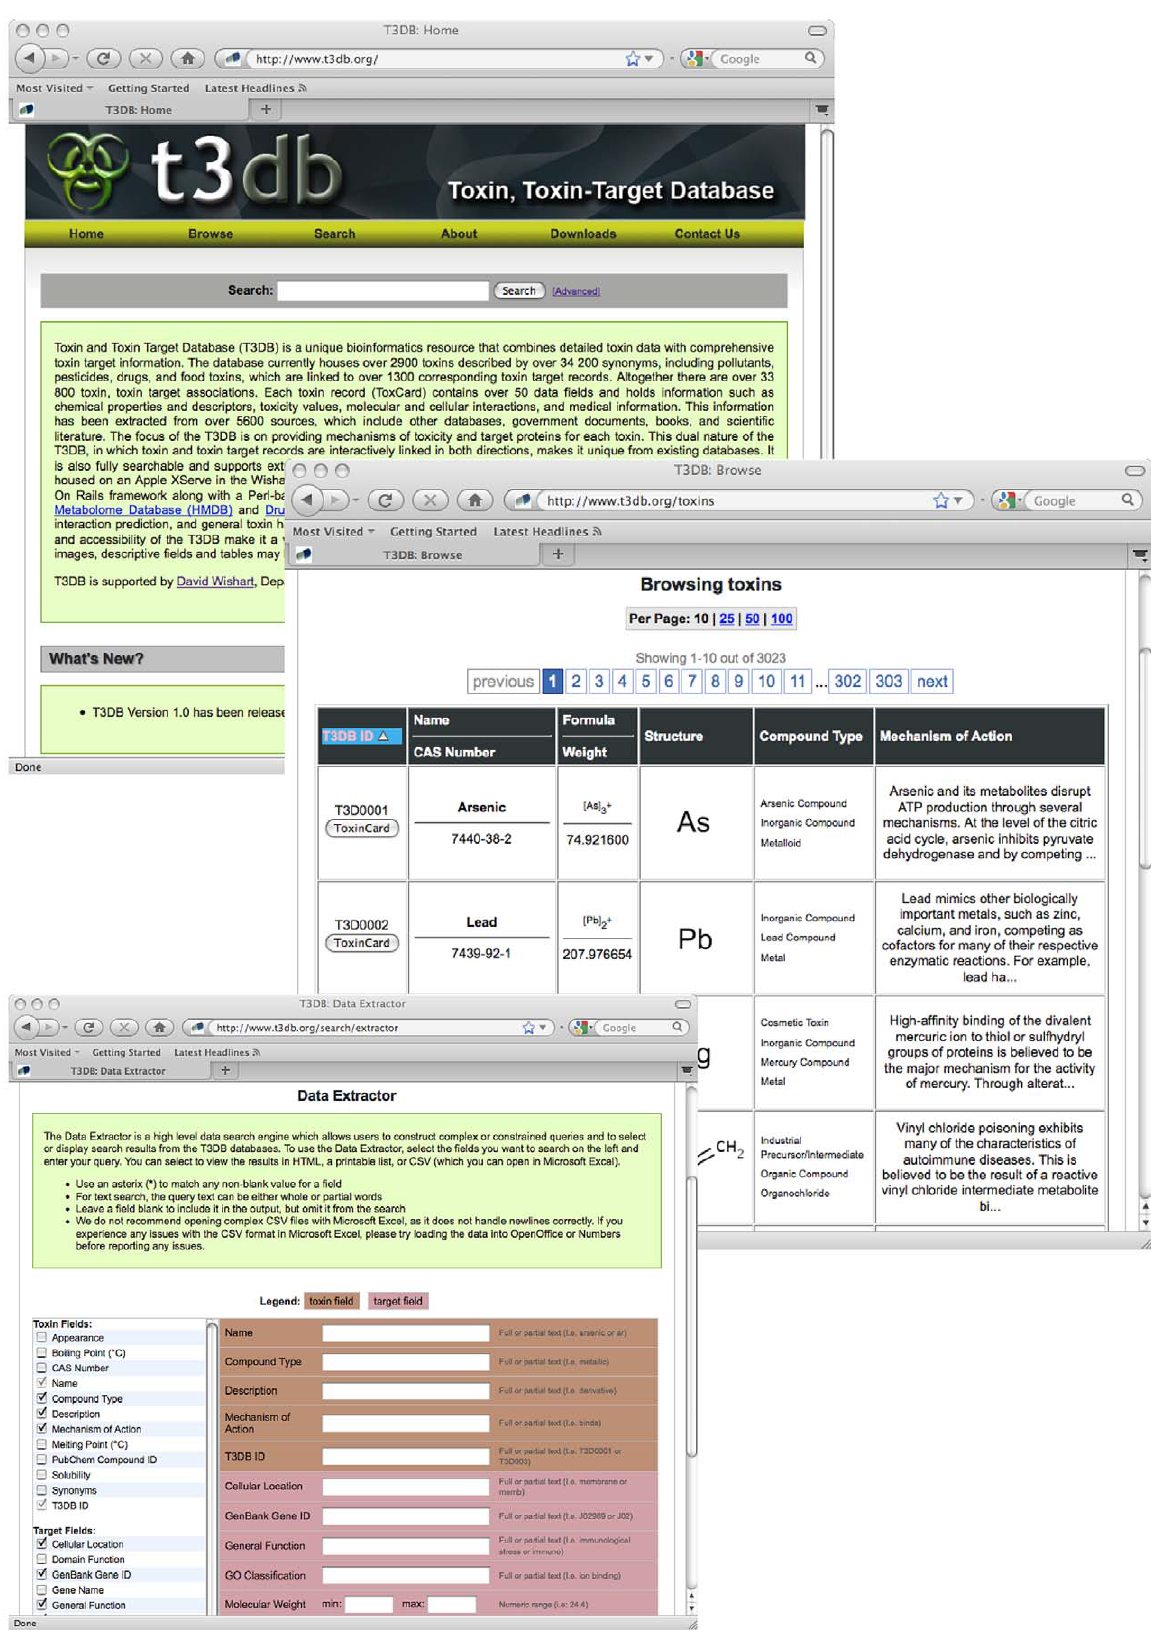
Figure 4. A screenshot montage illustrating the types of viewing and searching options available in T3DB (http://www.t3db.org). doi:10.1371/journal.pcbi.1002805.g004 PLOS Computational Biology |